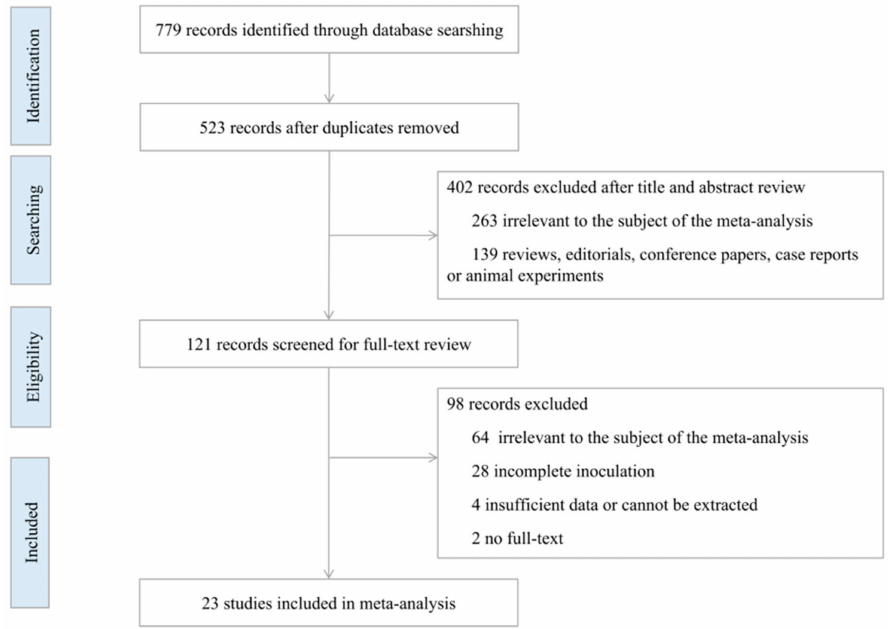
Figure 1. Flowchart of the study